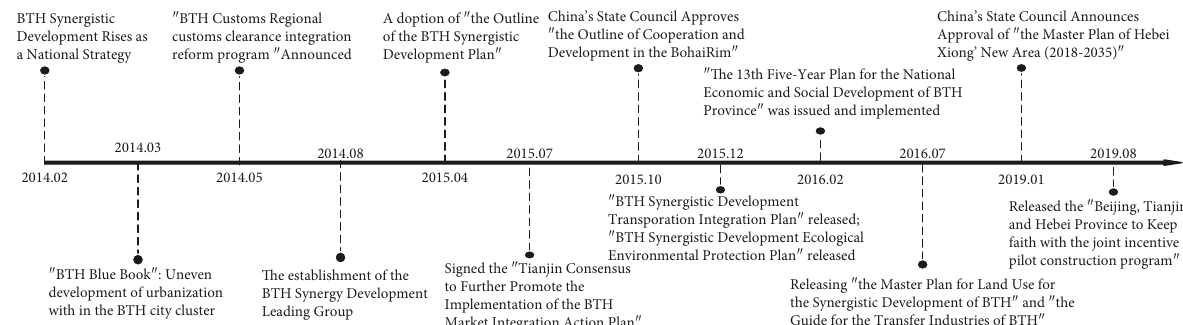
Figure 3: History of BTH synergistic development (after 2014).